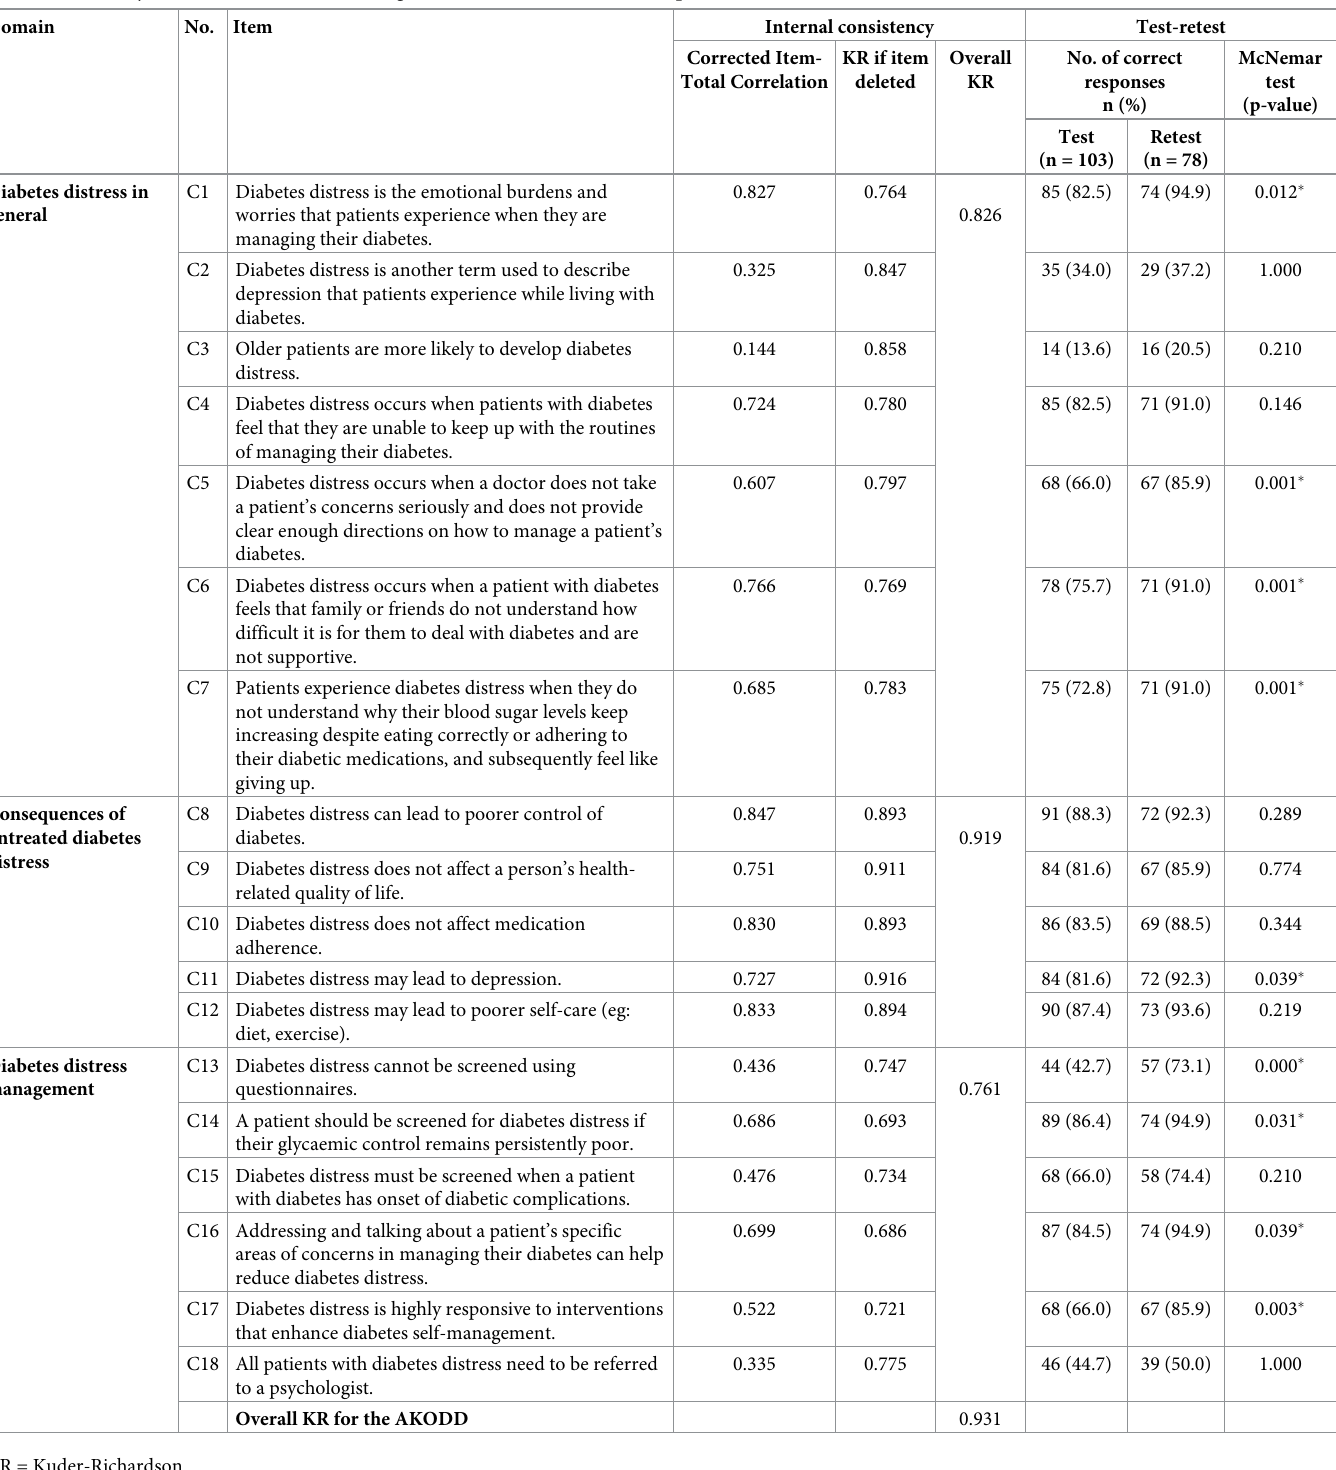
Table 4. Reliability of the awareness and knowledge of diabetes distress (AKODD) questionnaire.